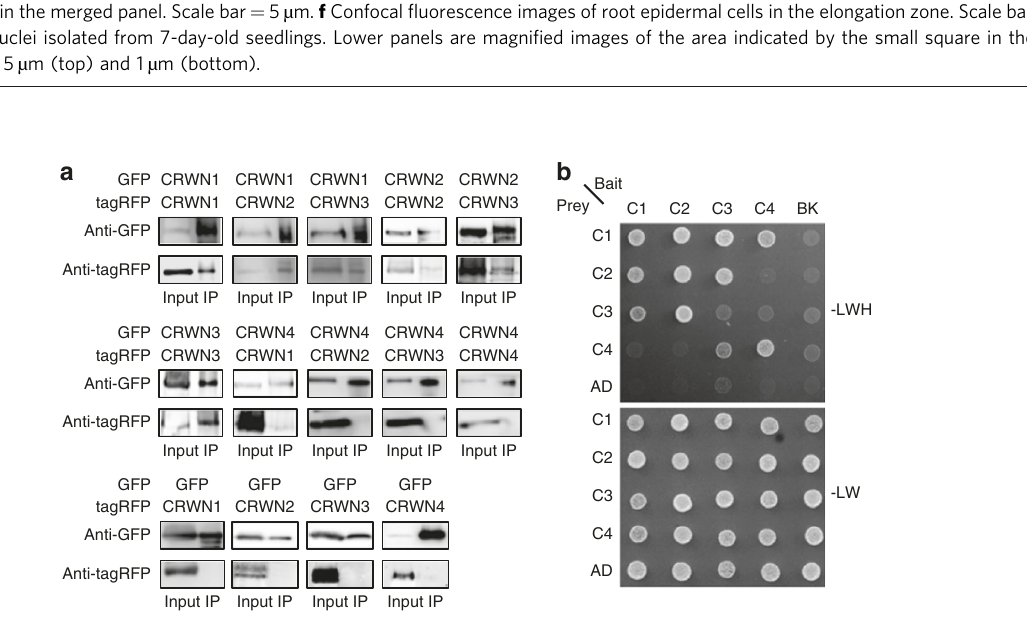
Fig. 2 Interactions among CRWNs. a Analysis of the interactions among CRWNs in Nicotiana benthamiana leaves detected by co-immunoprecipitation assay. Data are from single representative experiments that were reproduced twice. b Analysis of the CRWN interactions by yeast two-hybrid assay. Growth tests of yeast expressing CRWNs on agar plates lacking leucine, tryptophan, and histidine (top), or leucine and tryptophan (bottom). Empty vectors of bait (BK) and prey (AD) served as negative